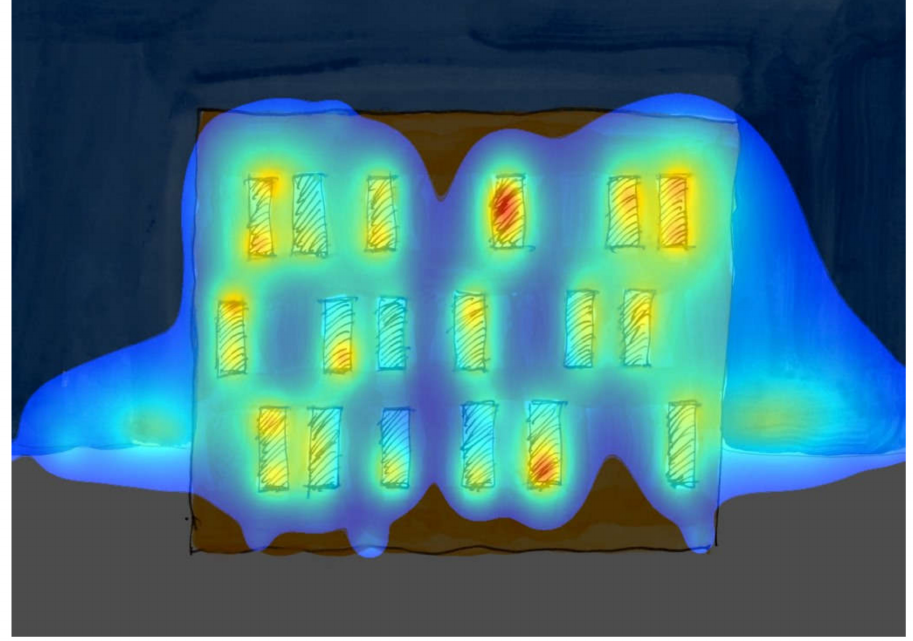
Figure 6. Heat map for contemporary building with vertical windows aligned